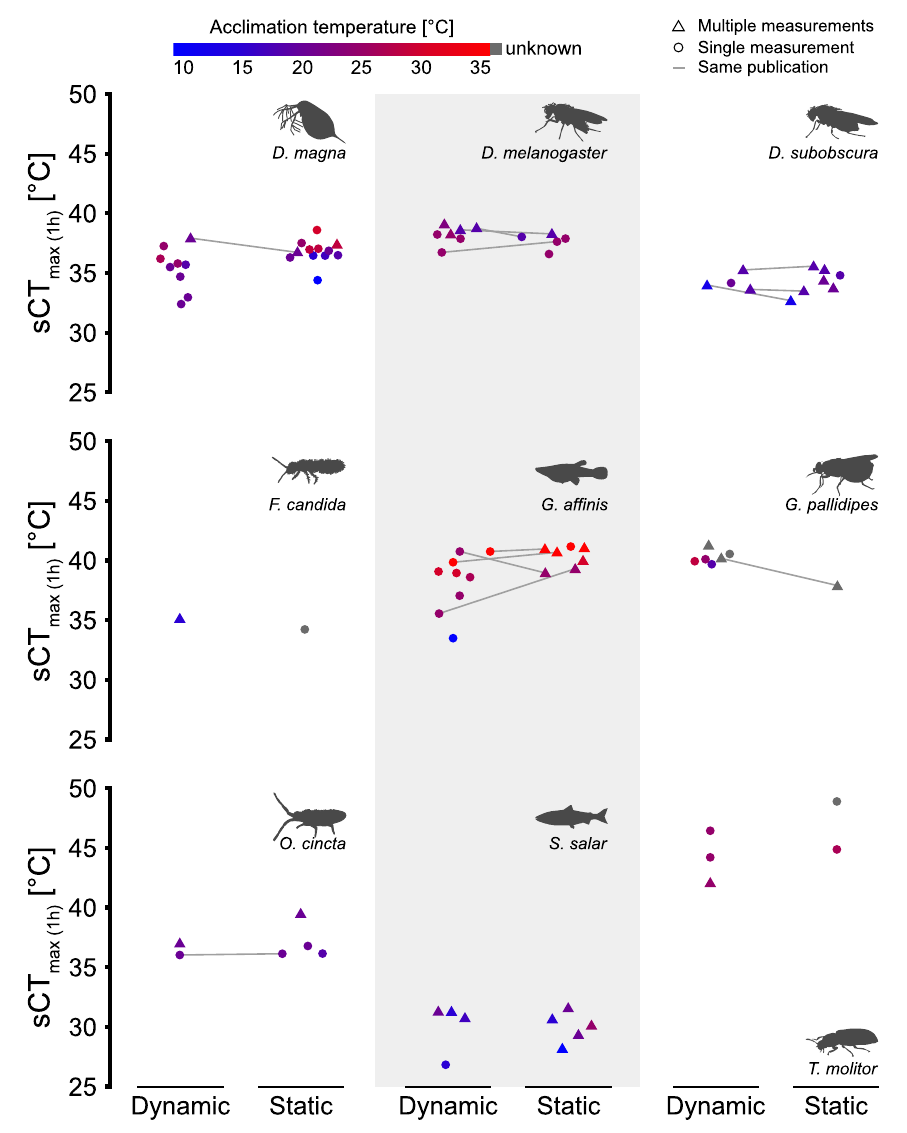
Figure 5. Heat tolerance measures from the literature re-calculated to the temperature resulting in heat failure after a 1-h exposure (sCT max (1 h) ). Heat tolerance measurements from both dynamic and static assays were obtained from the literature for nine ectothermic species and used as input for the associated R -scripts. If multiple measures of the same assay type were available in a publication (triangles), these measurements were used for TDT curve parameterization and then calculate sCT max (1 h) . If only a single measurement was available (circle) an estimated value of z was supplied to create a TDT curve for calculation of sCT max (1 h) (see main text). Connected points represent publications that provided both dynamic and static measures and colour indicates acclimation